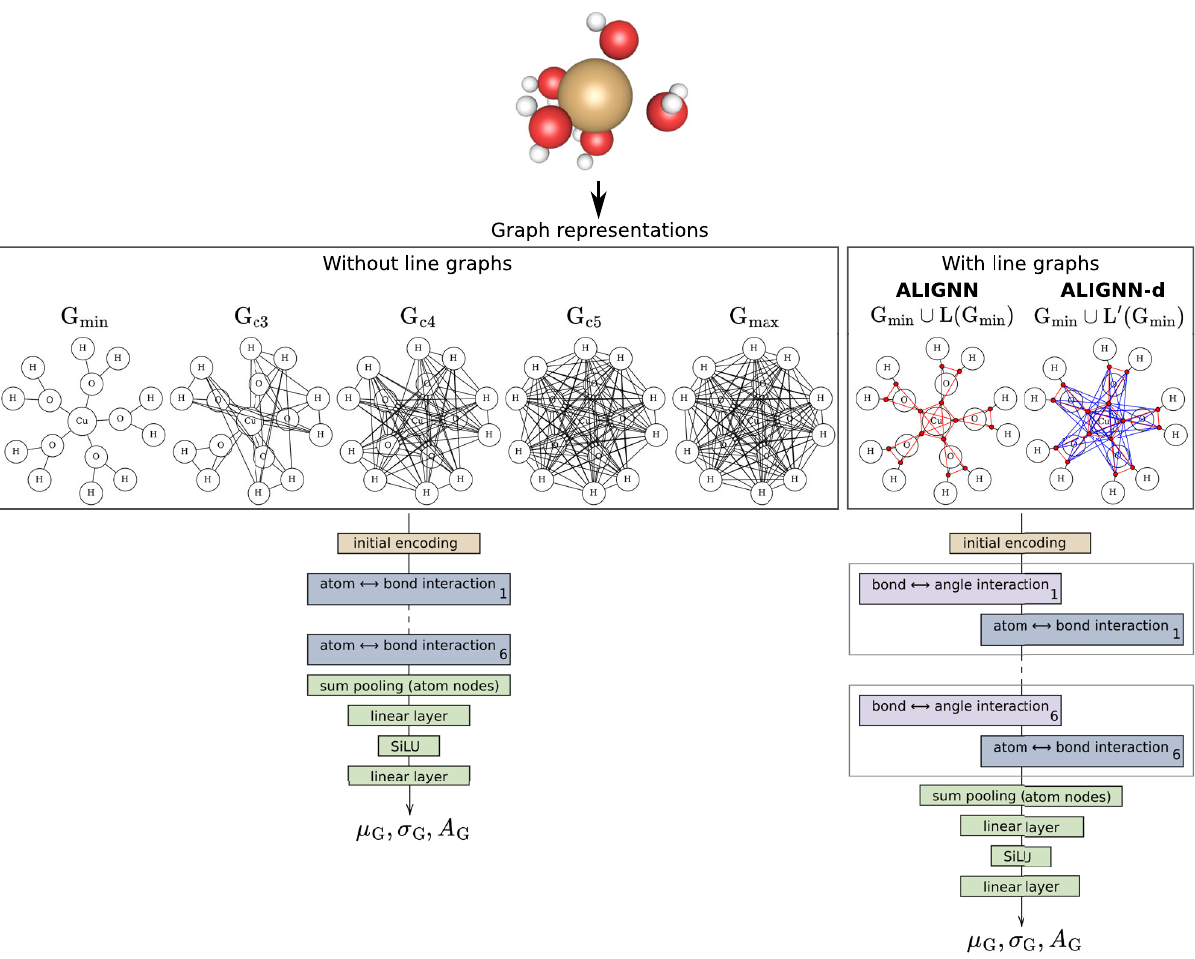
Fig. 3 The structure-to-spectrum fl ow consists of conversion to graph representation, followed by spectroscopy prediction from GNN layers. The different graph representations discussed in this work are shown schematically. Note that the edge distances in these visualizations do not re fl ect actual real space distances. The fi nal output is a Gaussian curve parameterized by mean μ G , standard deviation σ G , and amplitude A G , approximating the TDDFT-calculated discrete spectral peaks. This single-peak approximation is detailed in Supplementary Information (Supplementary Fig. As a key component of the work fl ow, we compare different graph representations for encoding the molecular structures. First, we consider the minimally connected graph G min that encodes only the minimal number of edges representing the nearest- neighbor atomic bonds. This graph contains the least structural information, as the bond angles and dihedral angles are not implicitly included. It can also be considered as the minimal spanning tree of the Cu(II) aqua complexes. Second, at the opposite extreme, we consider the maximally connected graph G max , which represents the brute-force approach that encodes all the pairwise bonds, thereby yielding complete geometric information 19 . Graph representations that lie between these two extremes are also considered. They are constructed using graphs de fi ned by a speci fi c cutoff radius, in which any pair of atoms within the cutoff distance are considered to be connected. Three values of the cutoff radius of 3, 4, and 5 Å are used, with corresponding graph representations denoted as G c3 , G c4 , and G c5 , respectively. Lastly, following the ALIGNN formula- tion, we incorporate angle information to G min by adding the corresponding line graph L(G), and we extend the ALIGNN formulation to explicitly represent both bond and dihedral angles in the line graph encoding, which is denoted as L 0 ð G Þ . Since L 0 ð G Þ